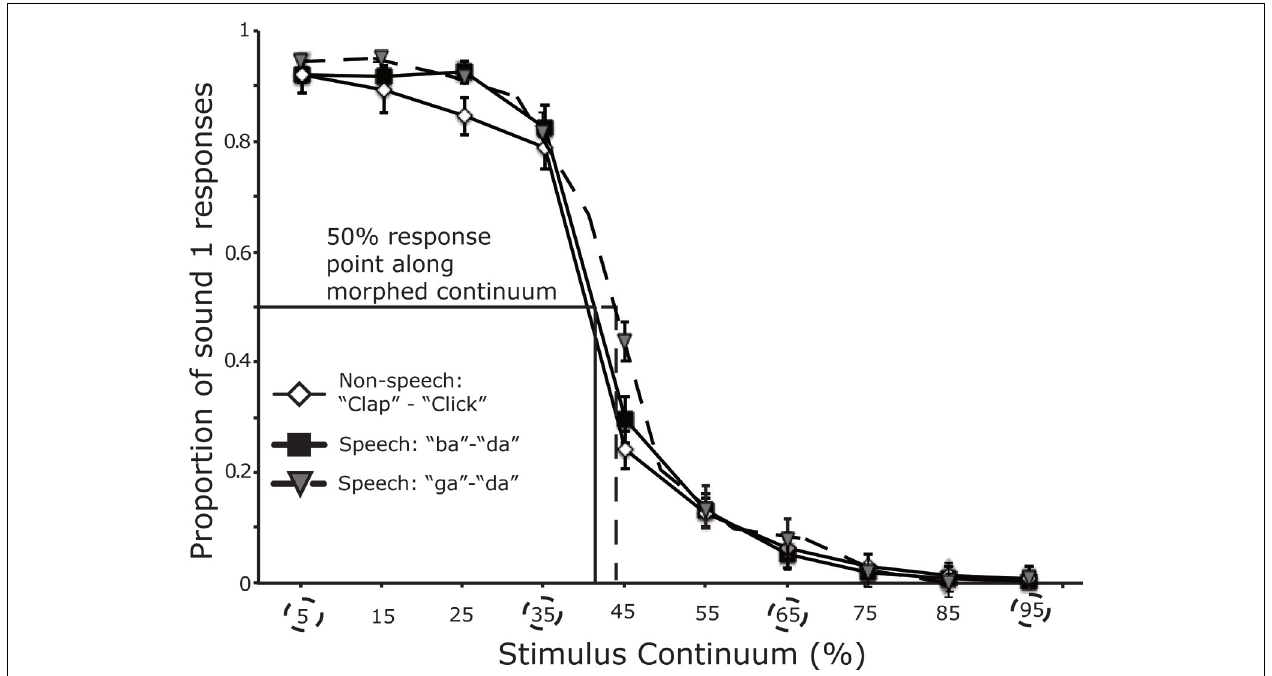
FIGURE 3 | Performance in the identification task (first session) across all participants. A logistic curve was fit to the raw data points across participants.The circles depict the points along the continuum defined as